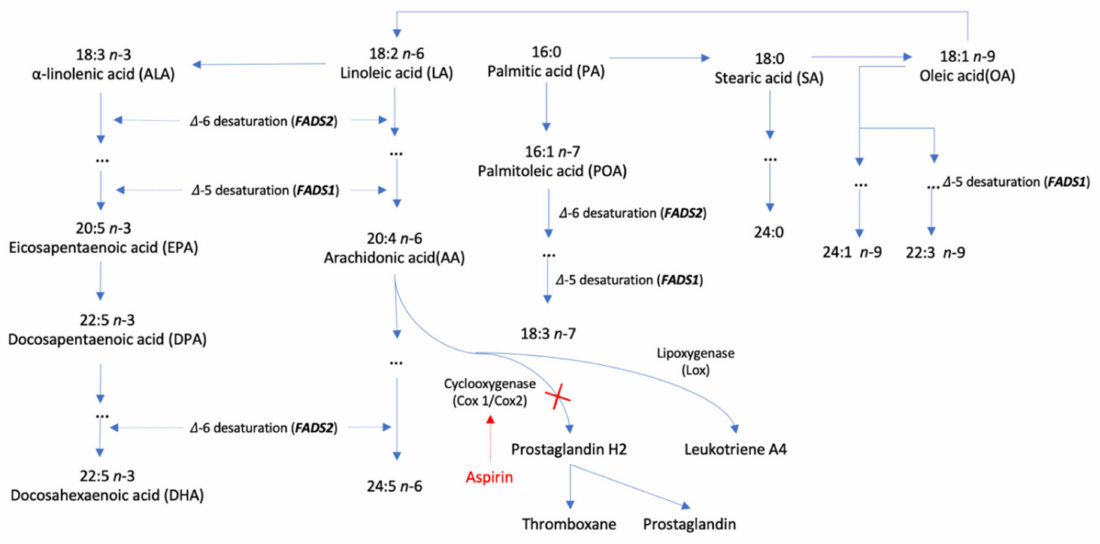
Figure 1. Metabolism of fatty acids and its relation to aspirin